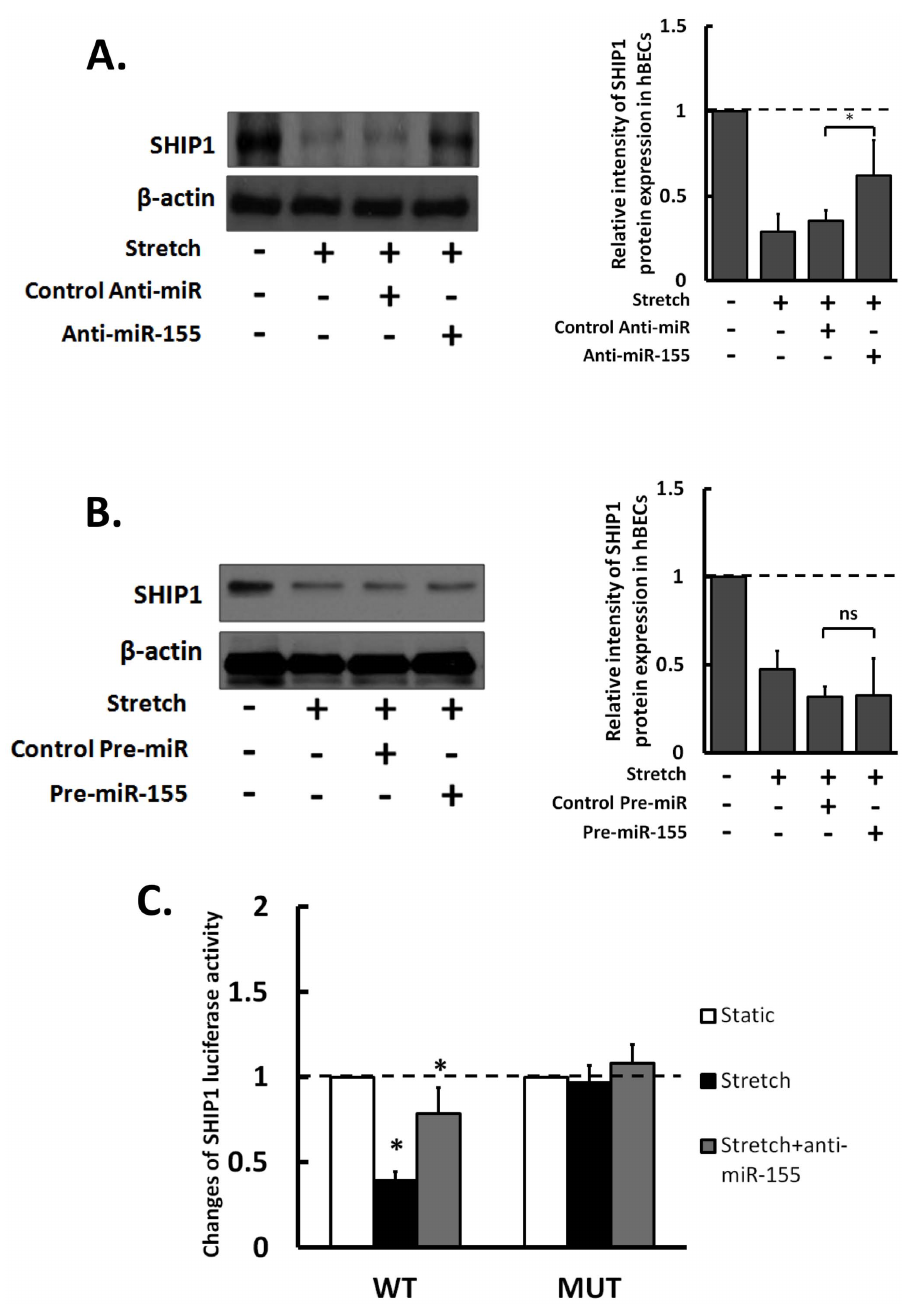
Figure 6. MiR-155 targeting SHIP1 under hyperstretch. Stretch-reduction of SHIP1 is reversed by anti-miR-155 (A), but not pre-miR-155 (C), compared with non-specific control anti-miR and control pre-miR, respectively. Relative intensity of SHIP1 protein expression was normalized to the expression of b -actin and static control. (C) Determination of SHIP1 is a direct target for miR-155 by using SHIP1 3 9 -UTR luciferase activity with/without anti-miR-155 treatment under hyperstretch. The changes in luciferase activity are relative to static control. Data represent mean 6 s.e.m. *, P , 0.05; n=5.